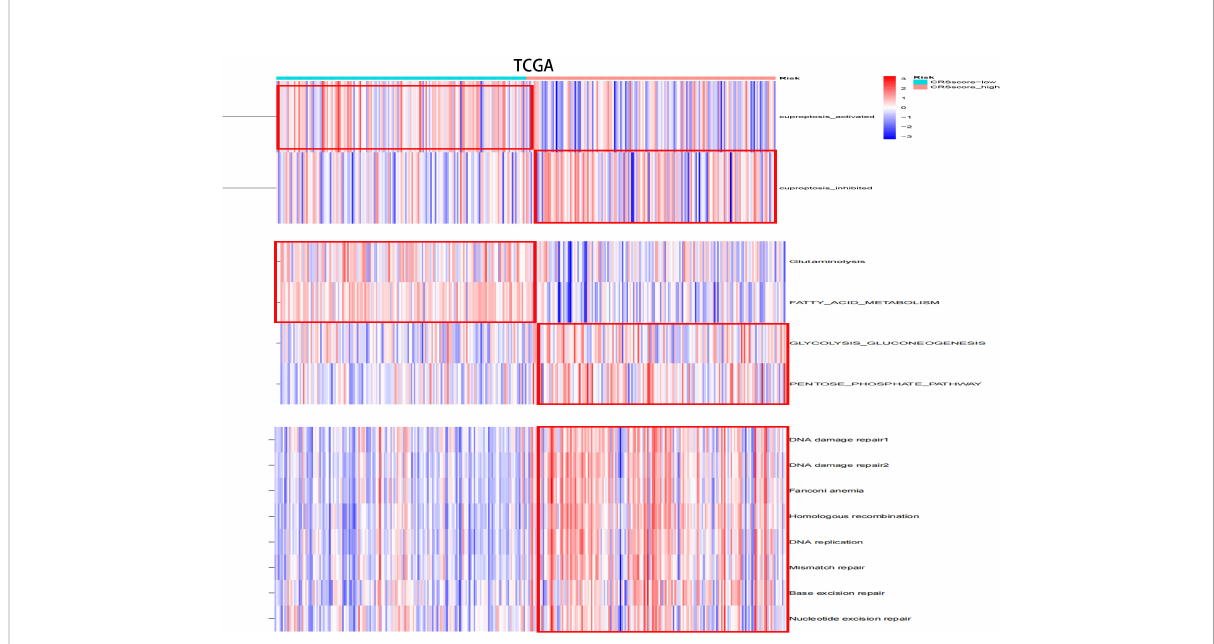
FIGURE 8 The variation scores of signi fi cant biological processes by ssGSEA analysis among risk subgroups in the TCGA